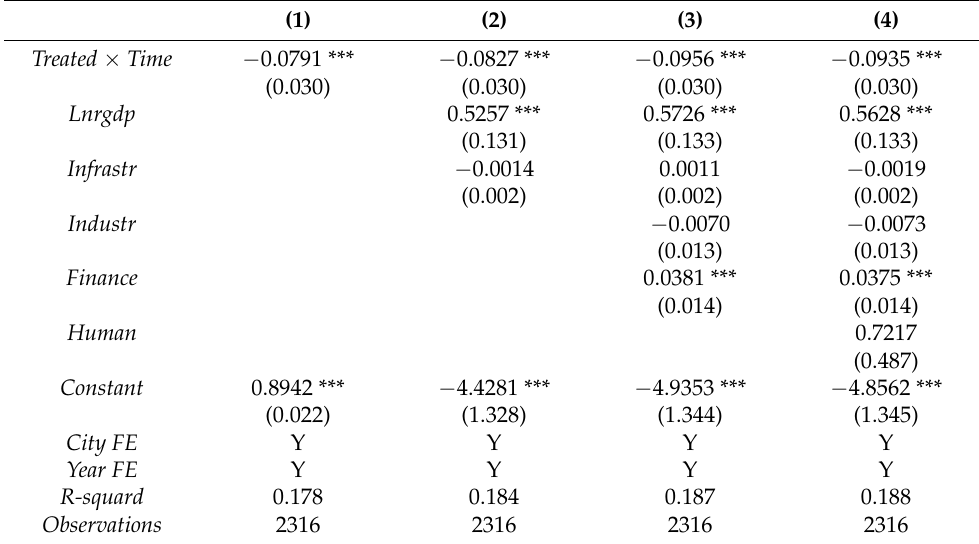
Table 4. Basic regression results using